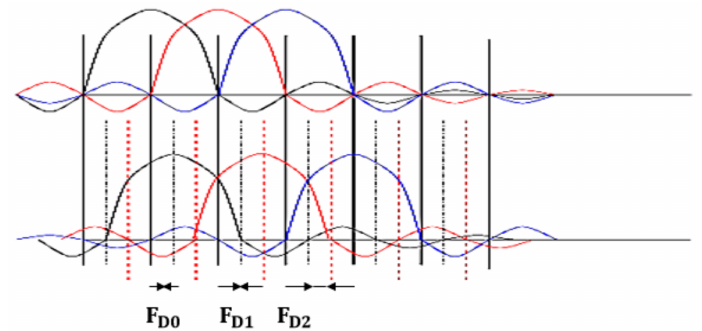
Figure 18. Doppler shifts varying effects over OFDM subcarriers